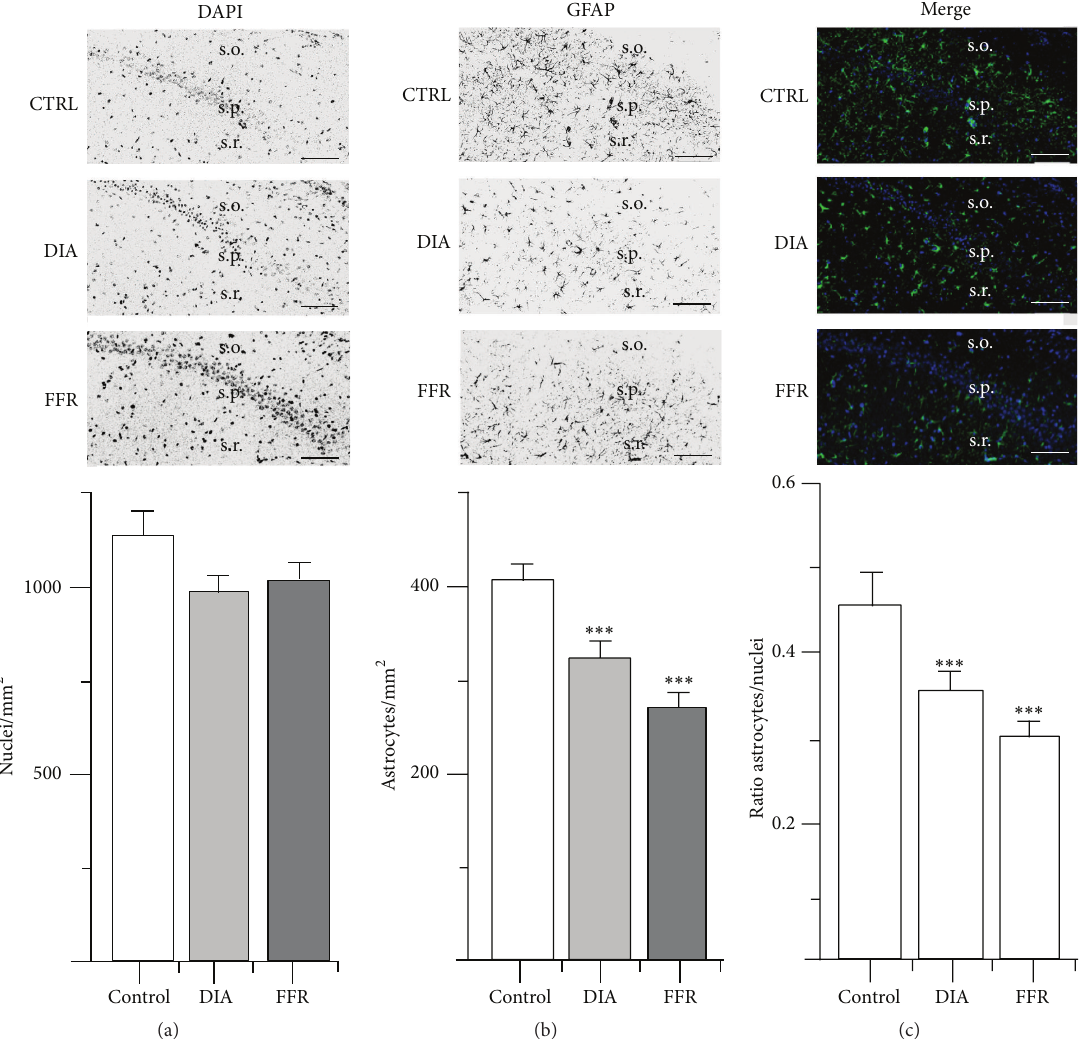
Figure 3: Effect of dehydration-induced anorexia (DIA) on astrocyte density of hippocampal region CA2. Coronal sections of the hippocampus show DAPI (a) or GFAP immunostaining (b). The overlay of DAPI and GFAP is shown for control, dehydration-induced anorexia (DIA), and forced-food restricted (FFR) experimental groups (c). The density of the nuclei was similar in all experimental groups ( 𝑝 = 0.467 ). However, a significant reduction of GFAP+ cells was observed for the DIA and FFR groups ( 𝑝 < 0.001 ). This reduction was consistently observed in the astrocyte/nuclei ratio ( 𝑝 = 0.008 ) (see Table 1). Nuclear and astrocyte densities were estimated in the stratum oriens (s.o.) and stratum radiatum (s.r.); stratum pyramidale (s.p.) is indicated as an anatomical reference. Scale bar = 50 𝜇 m. Data are expressed as mean ± SEM.